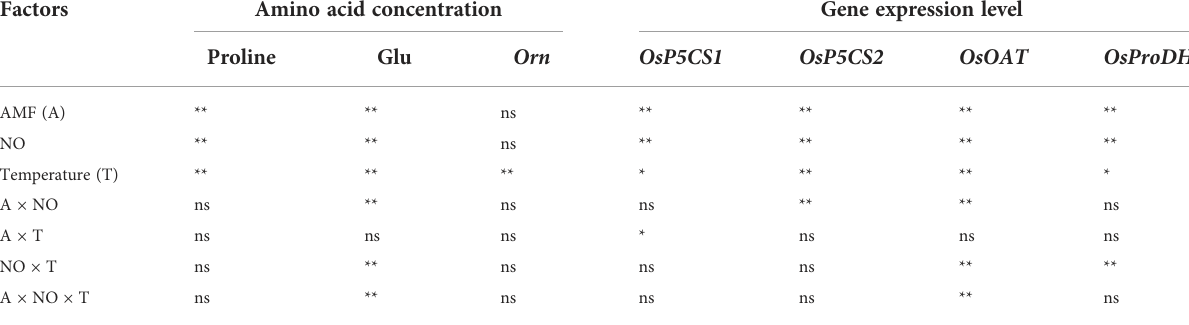
TABLE 3 Results of multiway ANOVA for analyses of differences in amino acid concentration and gene expression level in experiment 1. Factors Amino acid concentration